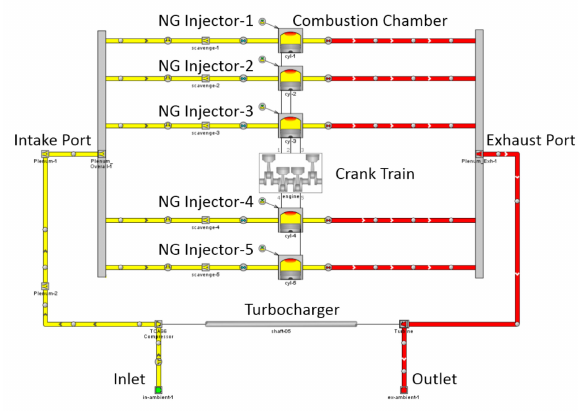
Figure 1. The 1D model of the 5RT-Flex50DF